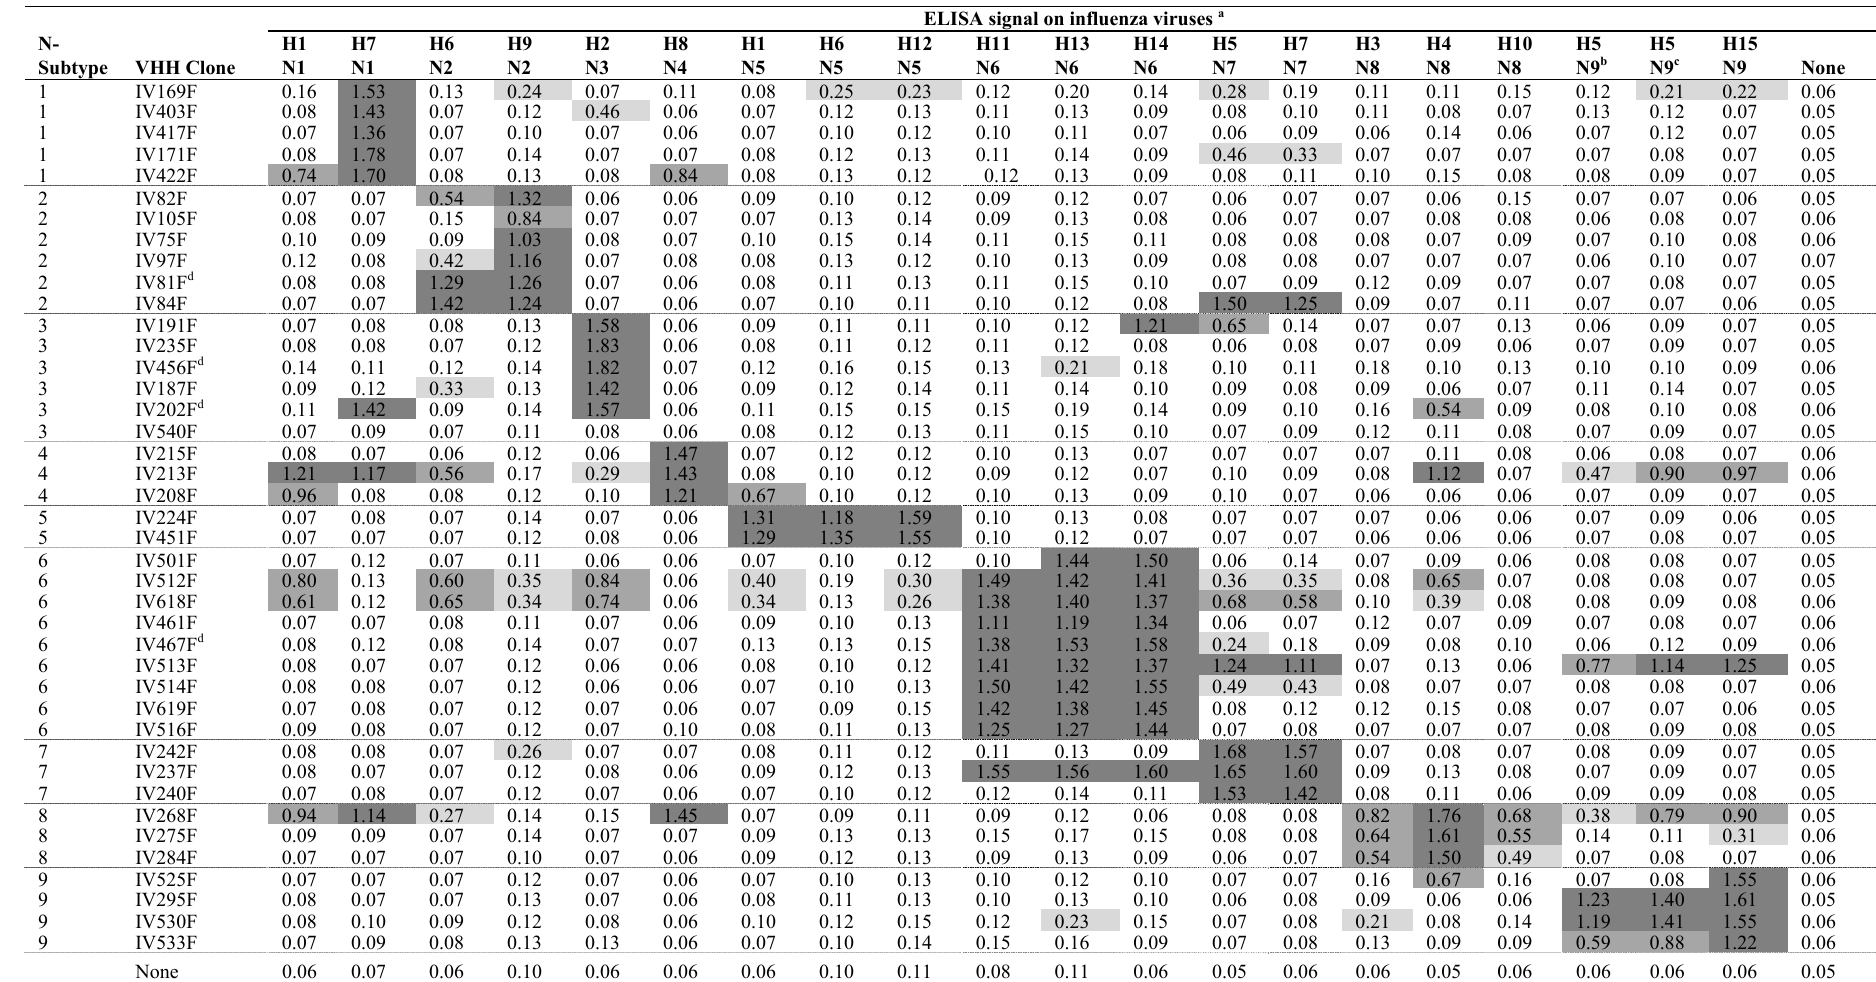
Table 6. Binding in ELISA of yeast-produced and biotinylated VHHs to influenza viruses of different subtypes. ELISA signal on influenza viruses